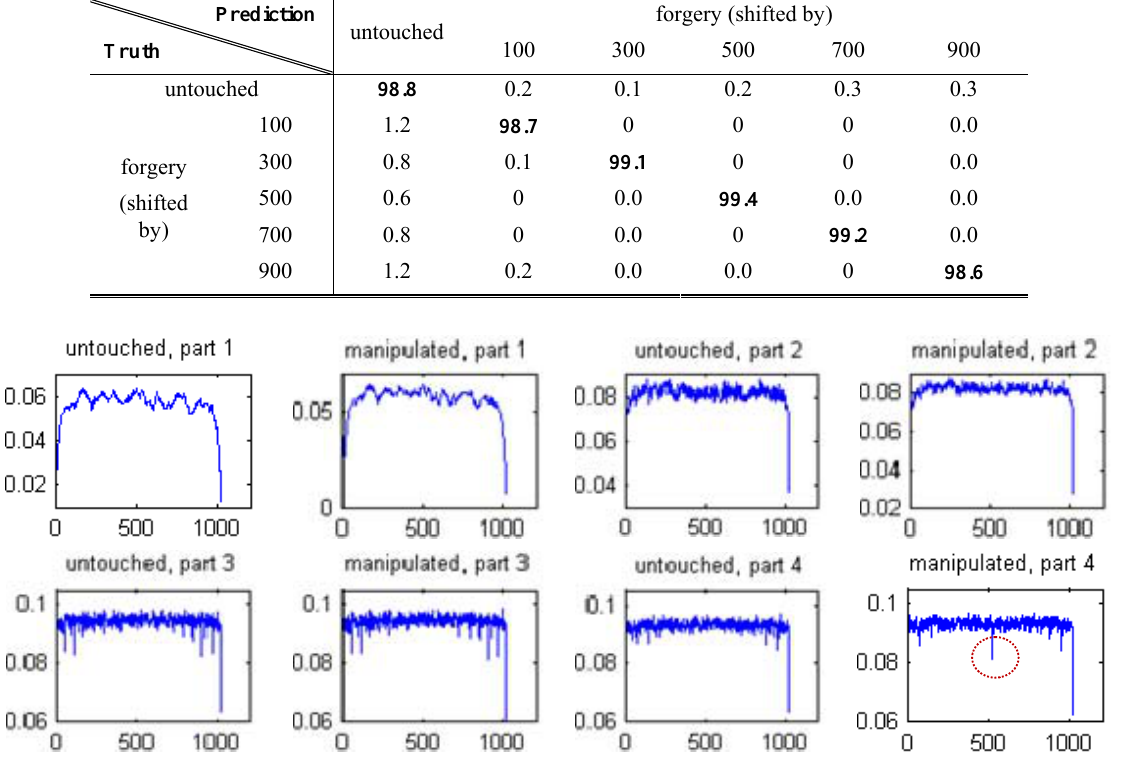
Table 2. Confusion matrix on testing sets (mean values, %) by using LibSVM with linear kernel over 100 experiments.